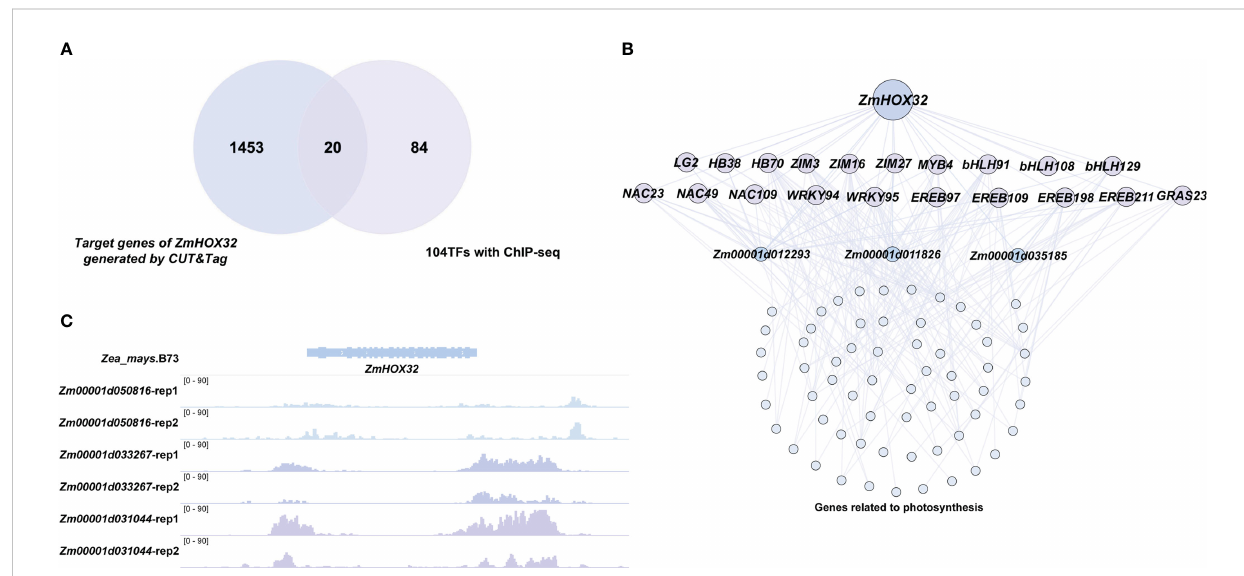
FIGURE 7 Characterization of the regulatory network of ZmHOX32 using the ChIP-seq data of 104 transcription factors. (A) Overlap of ZmHOX32 downstream target genes with 104 transcription factors. (B) Preliminary construction of the regulatory network of ZmHOX32 . (C) Transcriptional binding sites of three ZmHOX32 upstream transcription factors in the promoter region of ZmHOX32